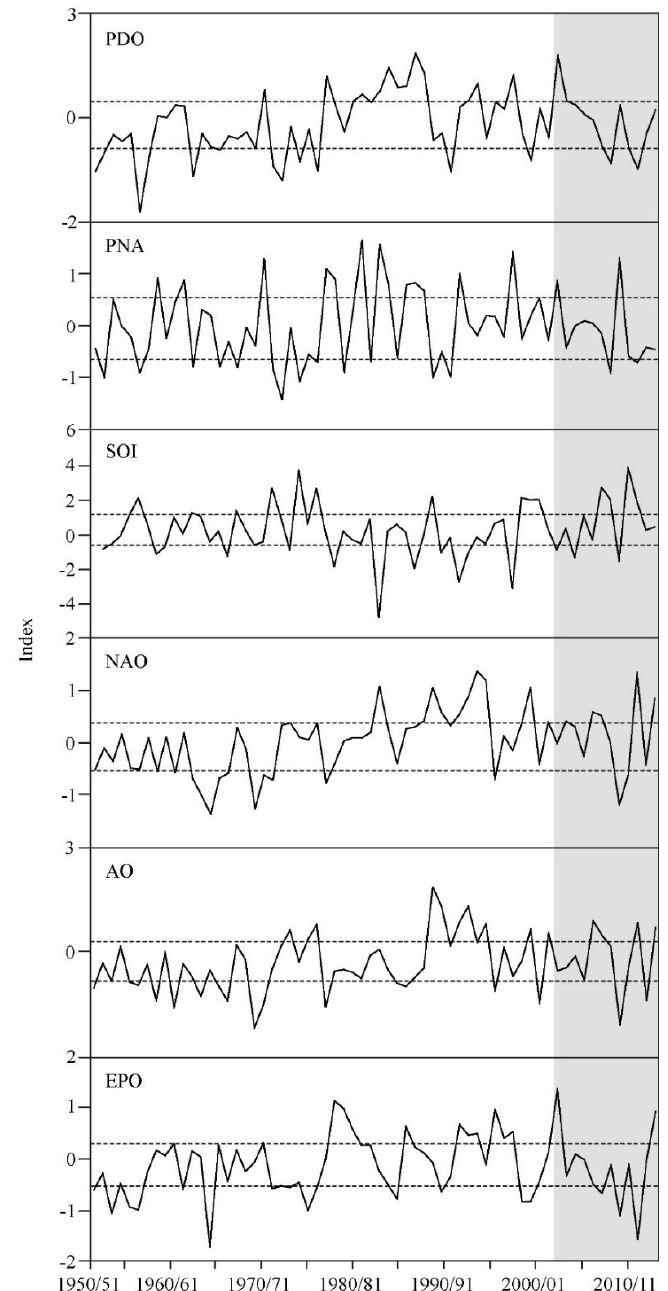
Figure 2. Time series of mean winter index values for each climate oscillation from 1950 to 2014. The last twelve years of the time series, within the grey box, are used for comparison with observed carbon flux data using the eddy covariance technique. Dotted lines for each oscillation are the upper and lower quartile thresholds used to determine which events/phases are moderate to